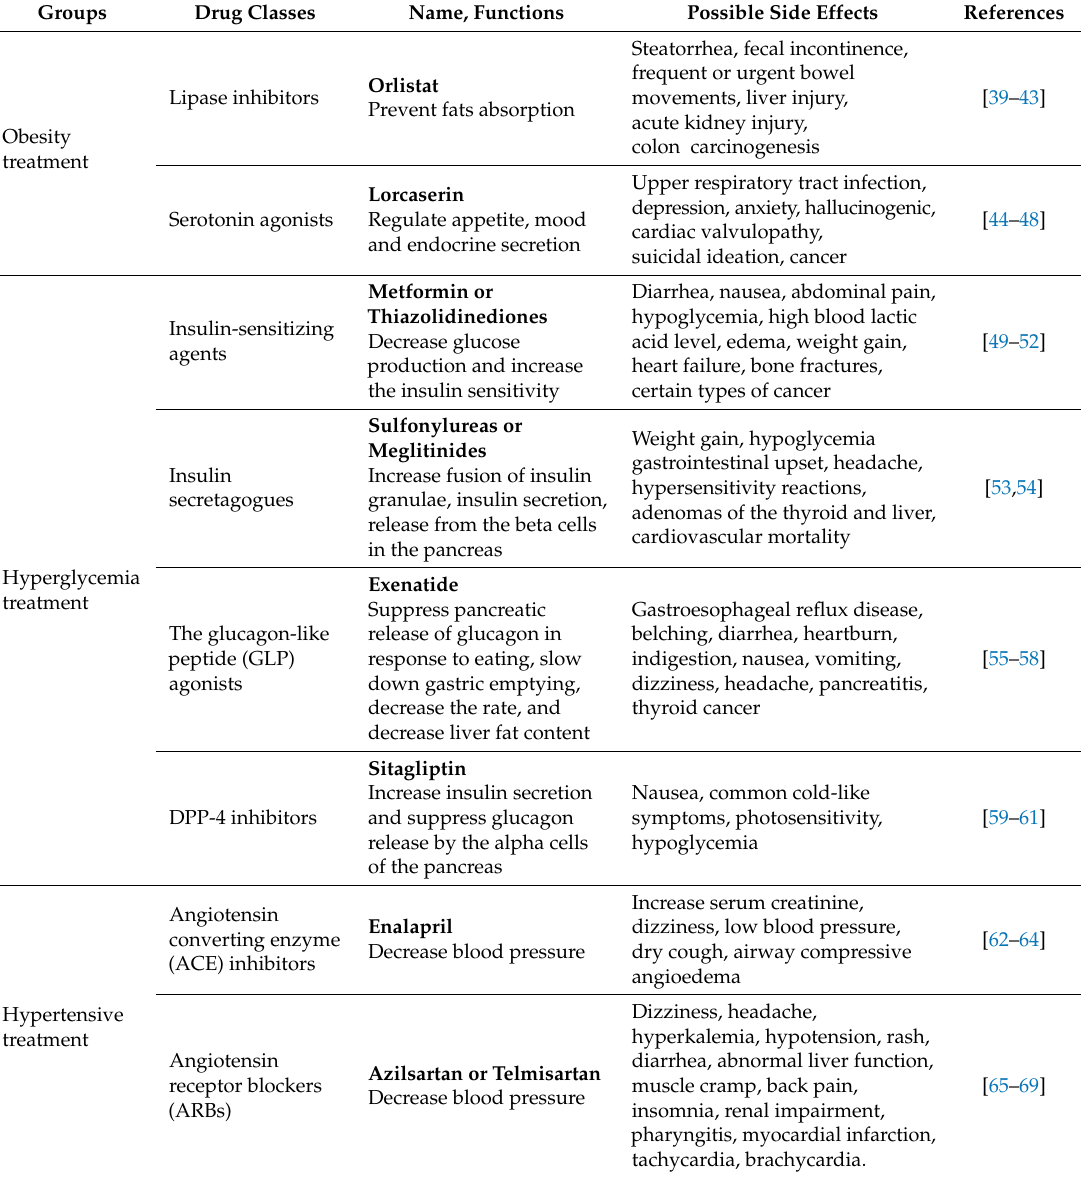
Table 1. Current pharmaceutical drugs for treating and preventing MetS and its related